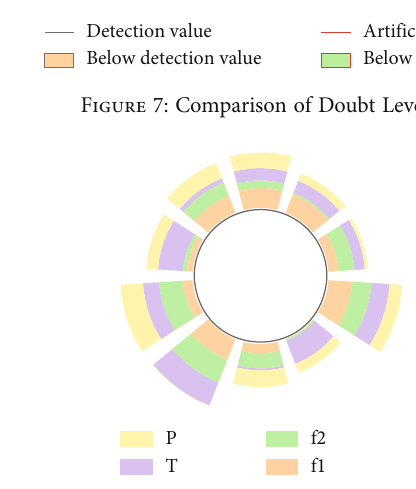
Figure 8: Experimental